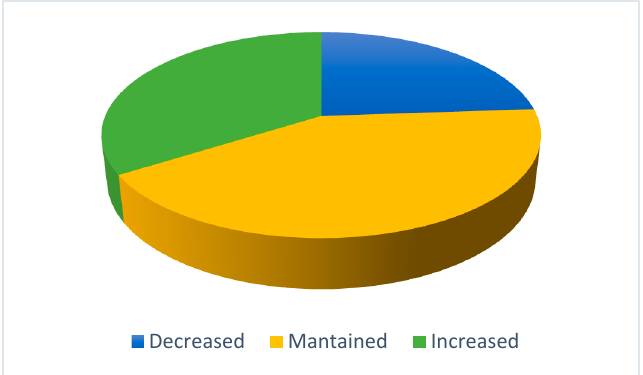
Figure 7. Productivity in telework.